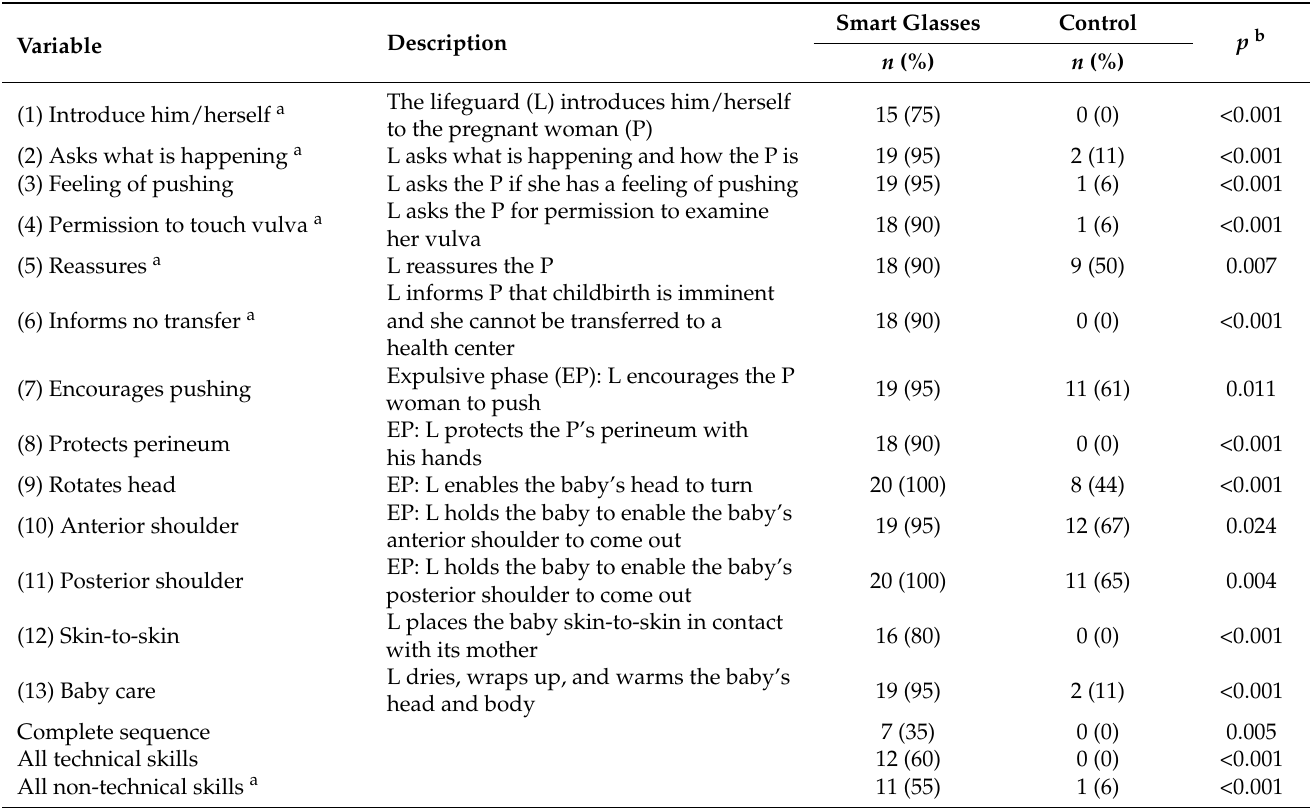
Table 2. Participants in the smart glasses video assistance group and control group who correctly performed the different techniques of the out-of-hospital birth sequence.